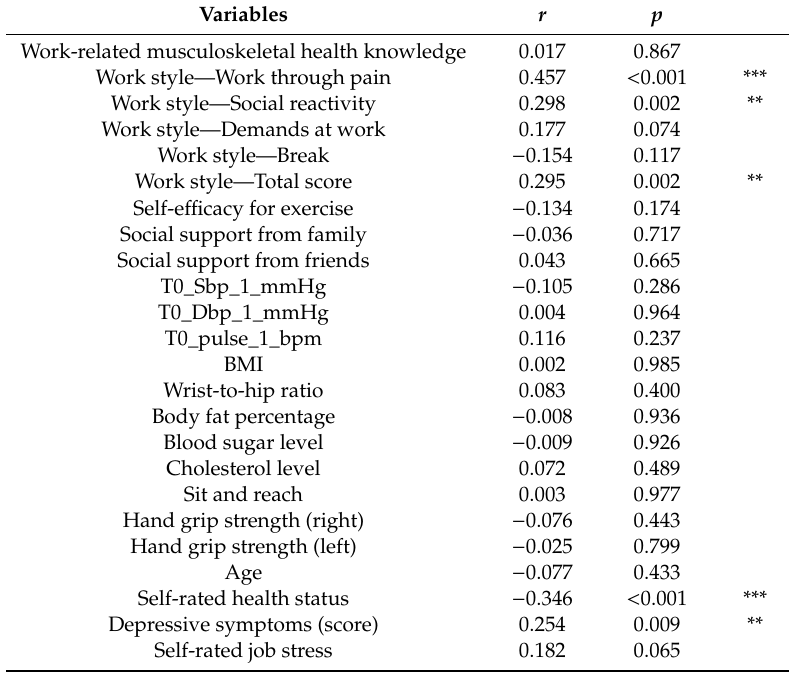
Table 2. Correlation table with the number of body parts with WRMSs at baseline